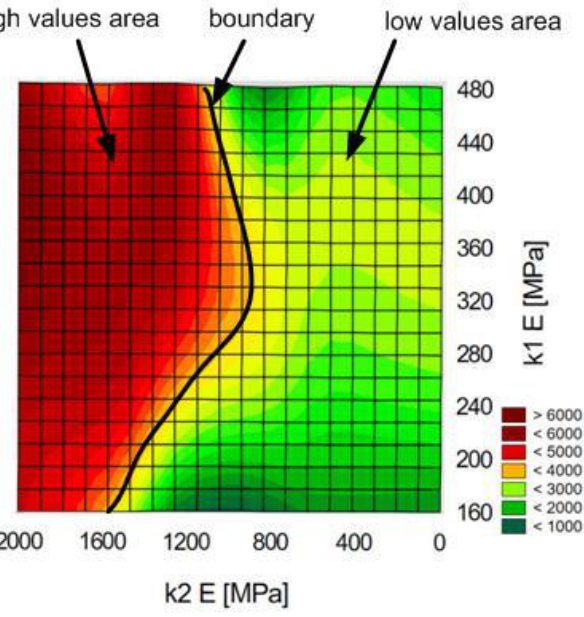
Figure 16. Diagram of force values [N] in function of Young’s moduli of both adhesives.